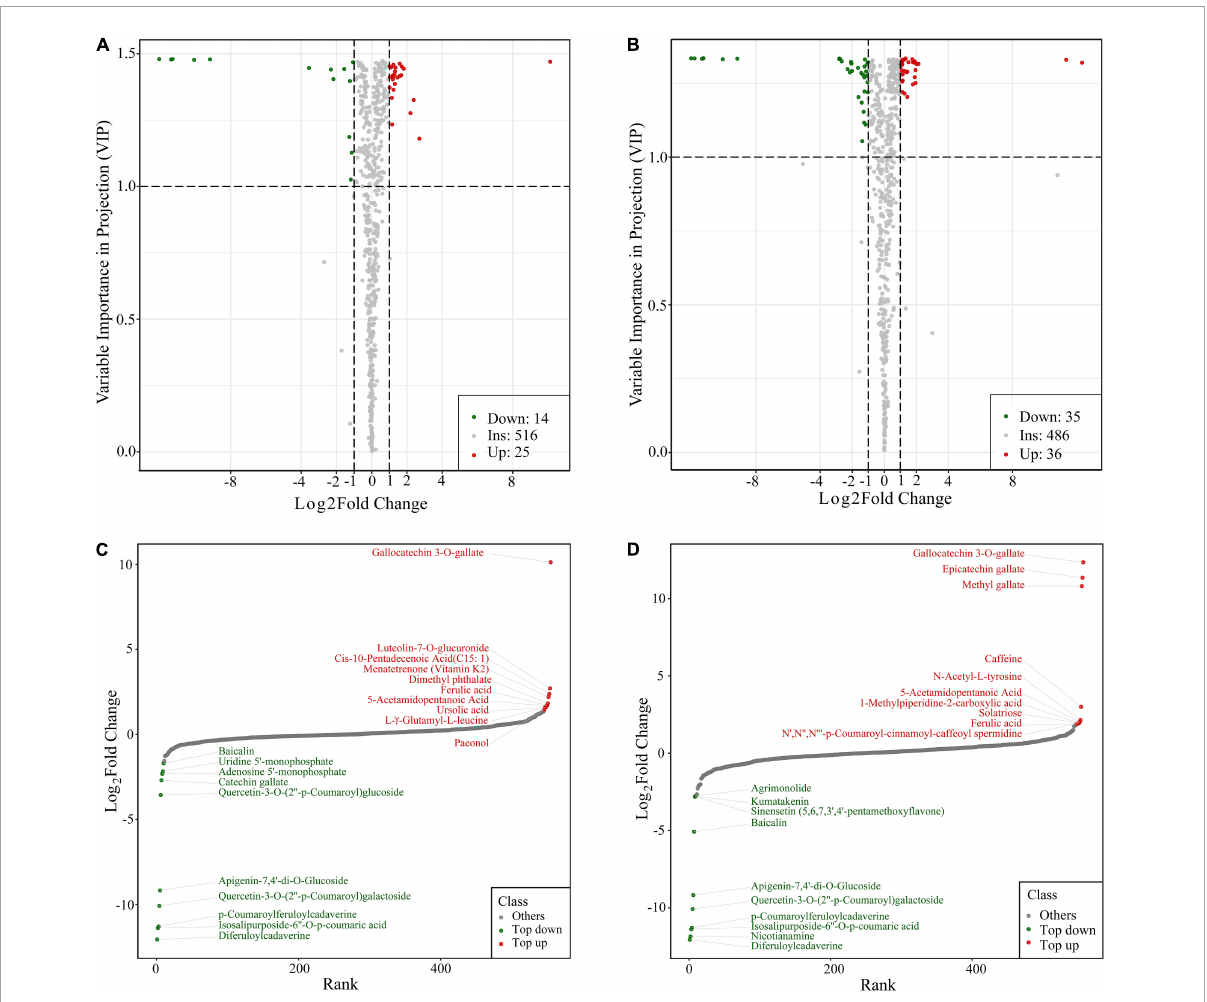
FIGURE3 Identification of differently accumulated metabolites in the Antarctic moss Pohlia nutans under cold stress. (A,B) The volcano plot showing the contents of metabolites and the statistical significance. (A) , Cold_24 h vs. CK. (B) , Cold_60 h vs. CK. Each point represents a metabolite. Horizontal ordinate indicates the fold change of metabolites between two groups, while VIP value represents significant difference in statistical analysis. (C,D) The fold change of the top 20 different metabolites between two groups. (C) , Cold_24 h vs. CK. (D) , Cold_60 h vs.